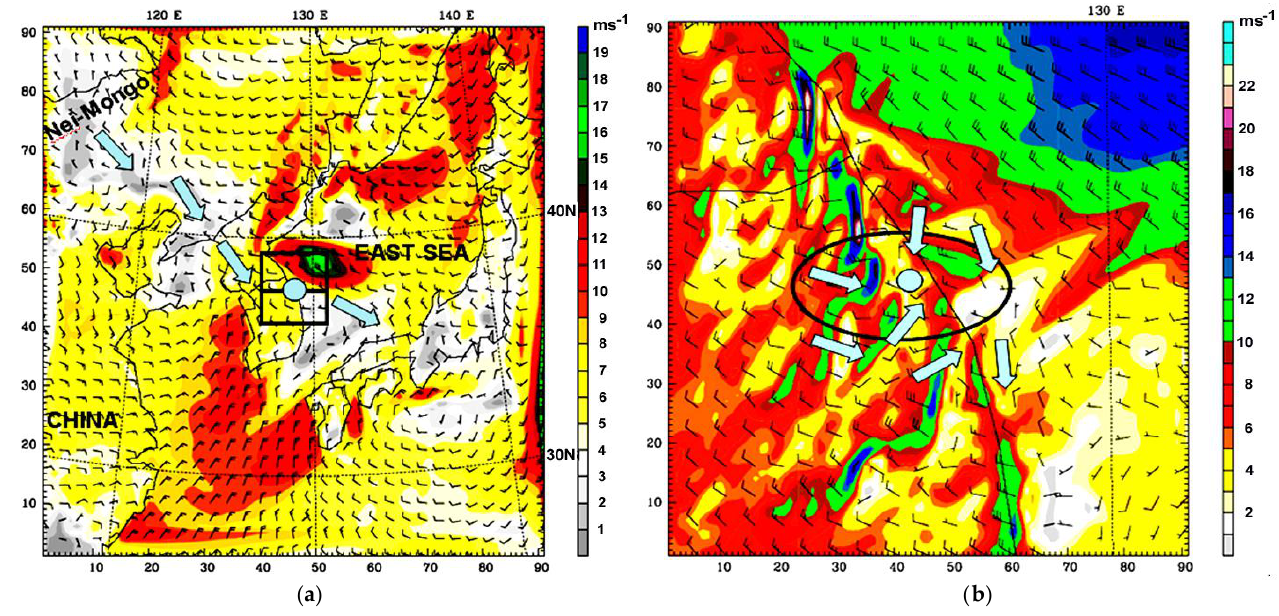
Figure 16. Surface wind (m/s) ( a ) in north-eastern Asia including Gangneung city on the Korean east coast (a small square) at 20:00 LST, 30 March 2004, and ( b ) the vicinity of Gangneung city, respectively. Arrow, a small circle in ( a ) and large and small circles in ( b ) denote air flow, Gangneung city, Gangneung city including its coast and downtown, respectively. Northwesterly wind induced hige amounts of dust from Nei-Mongo into Gangneung city in ( a ), and the transported dust combining with pollutants emitted from the city was trapped inside of the city by opposite easterly wind from the East Sea in ( b ), resulting in the maximum PM concentration.